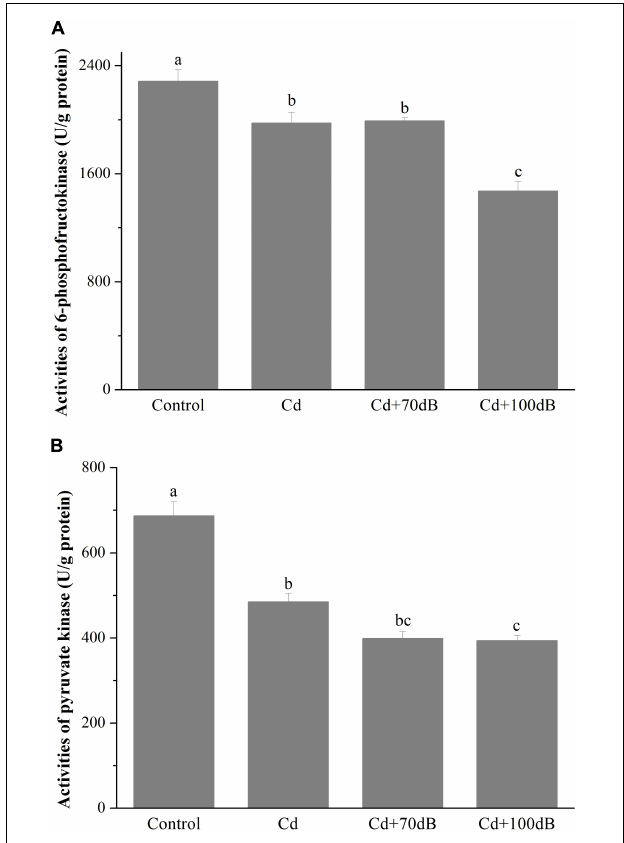
FIGURE 3 | Activities of 6-phosphofructokinase (PFK) (A) and pyruvate kinase (PK) (B) in the tissues of the blood clams after 10 days of exposure to the control (without Cd and anthropogenic noise), 50 µ g/L Cd, 50 µ g/L Cd + 70 dB re 1 µ Pa anthropogenic noise, and 50 µ g/L Cd + 100 dB re 1 µ Pa anthropogenic noise. Means not sharing the same superscript are significantly different.